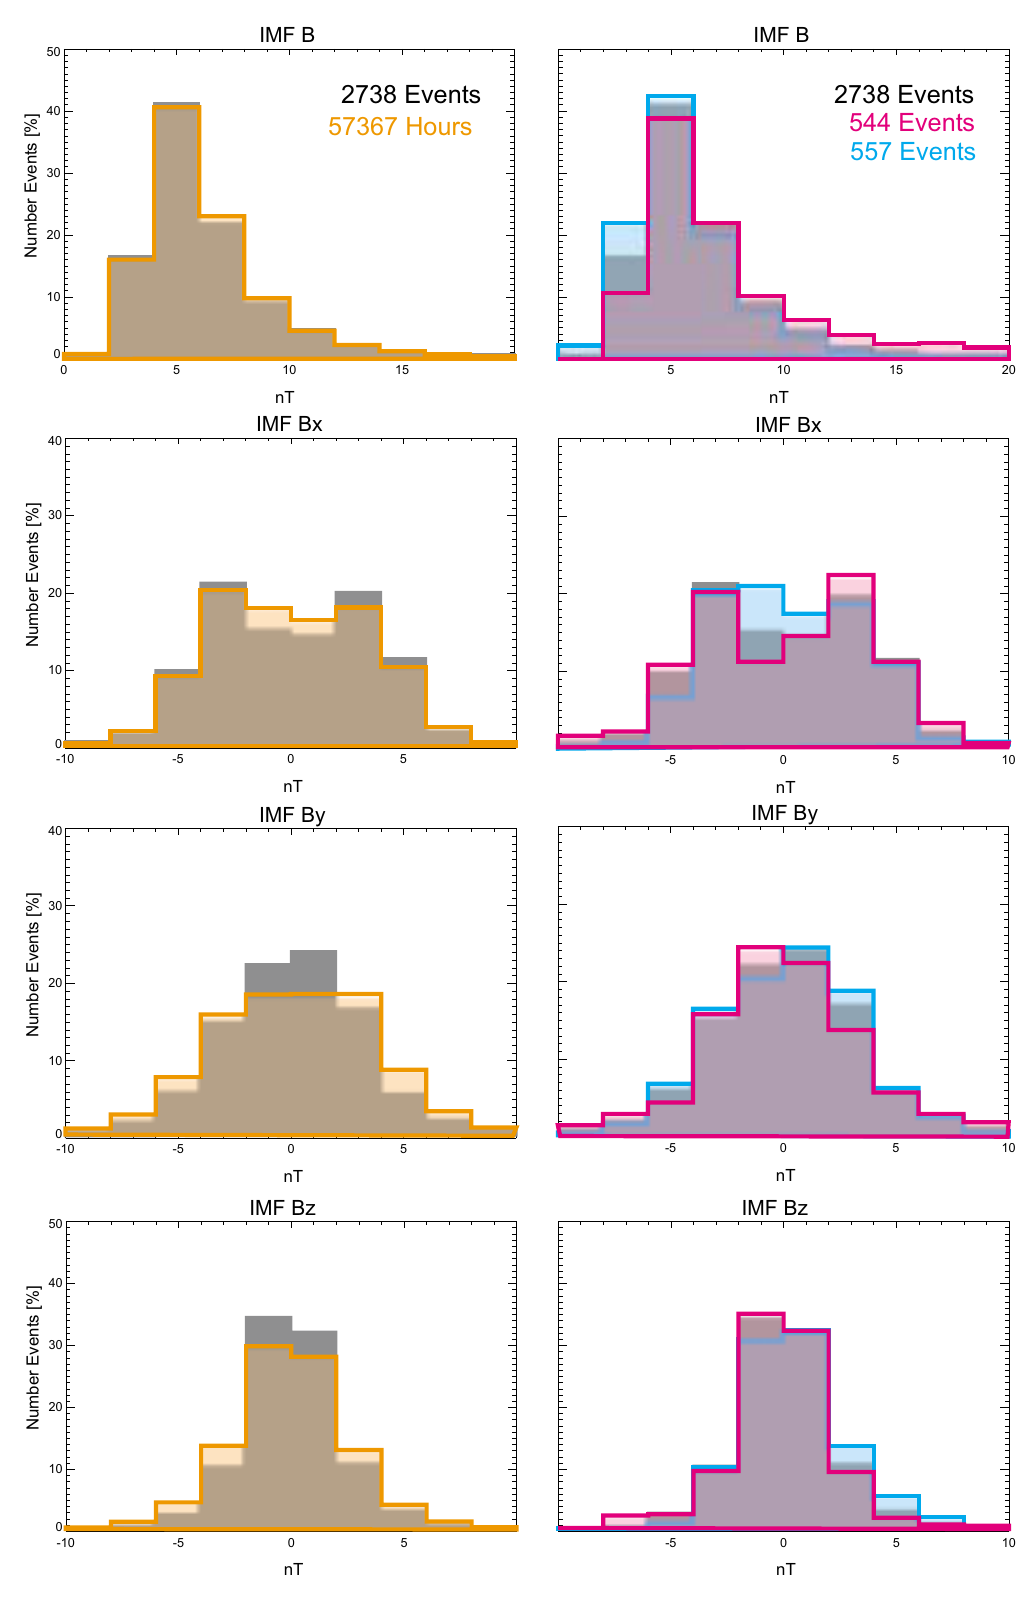
Fig. 17. Relative occurrences as functions of IMF values at the time of events. In all panels, the gray block diagrams present the distributions for all events. For reference, the background distributions for the entire period covered in the analysis (57367h for which OMNI IMF data exist) are displayed in orange for the total field (top) and each component (continuing down) in the panels on the left. In the panels on the right we show the total field (top) and the separate distributions for each component (continuing down) for the large (magenta) and small (cyan) amplitude subgroups of